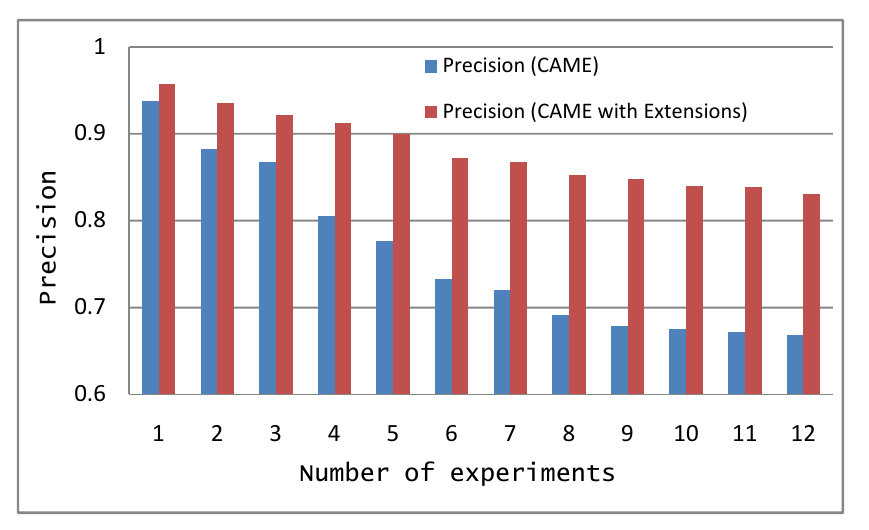
Figure 7. Comparison between CAME and extended CAME precision for 12 different experiments with increasing numbers of